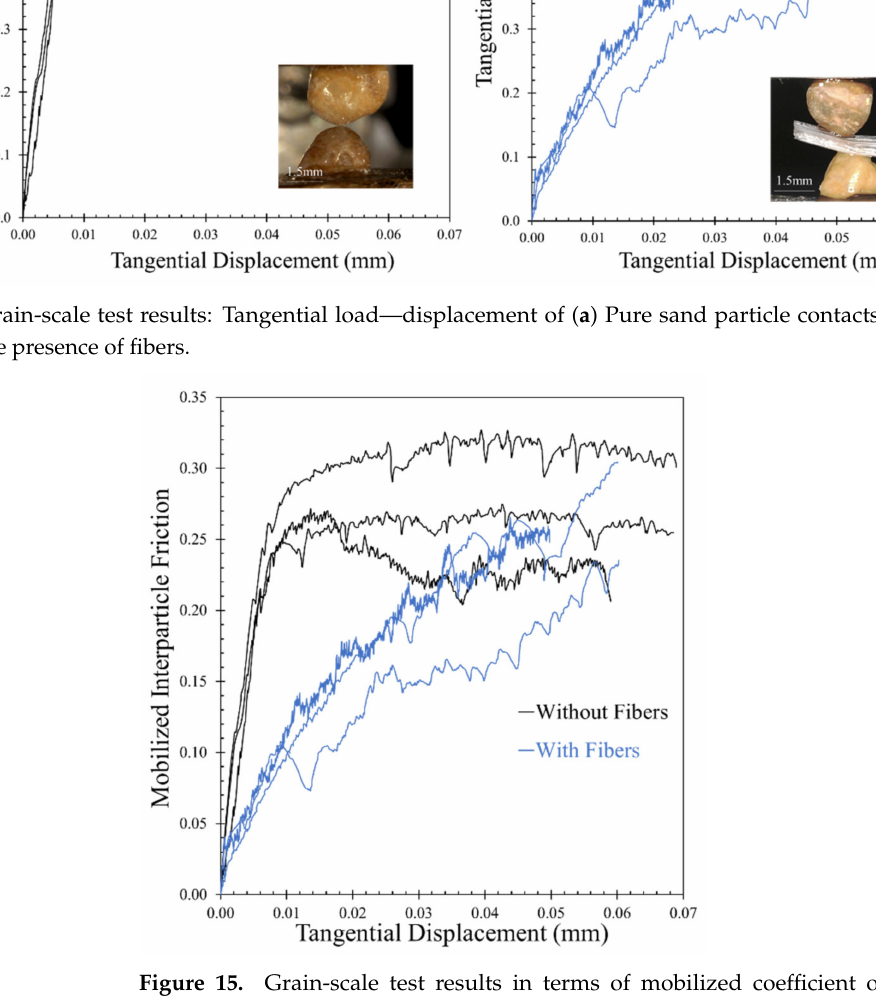
Figure 15. Grain-scale test results in terms of mobilized coefficient of (interparticle) friction against